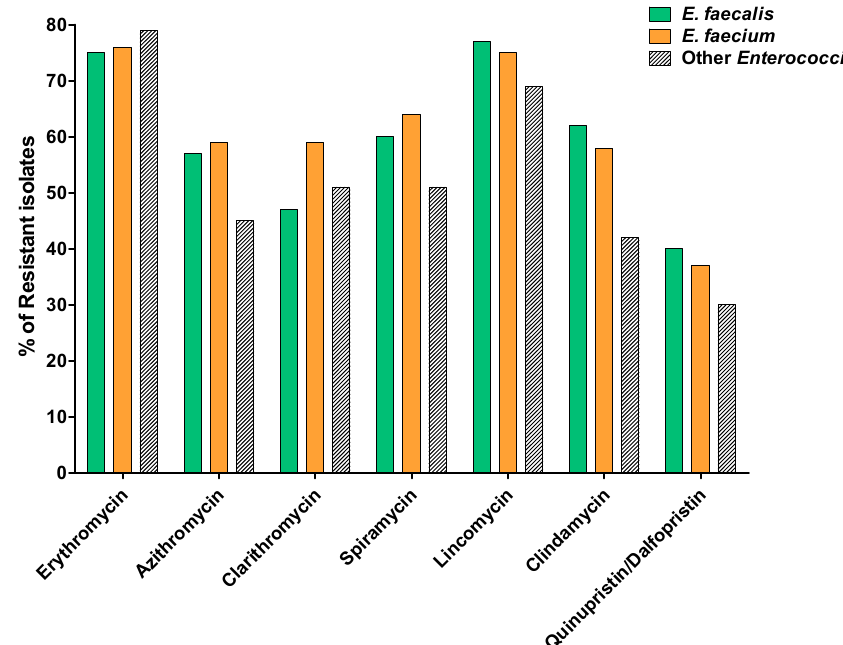
Figure 2. Percentages of resistance to tested MLS antibiotics. The chi-square test was used to compare the difference in the percentages of resistant isolates to tested antibiotics. There was no significant difference in the resistance of different Enterococci spp. to tested antibiotics; ( χ 2 ( 10 ) = 4.98, p = 0.892).